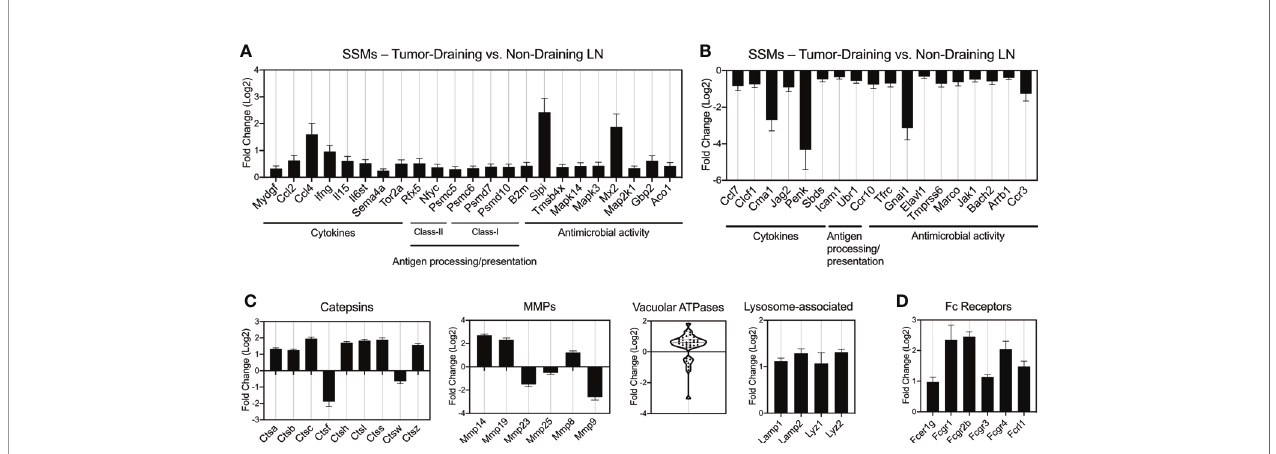
FIGURE 4 | Gene families differentially regulated by tumors in SSMs. (A, B) Immune gene lists from the ImmPort project: cytokines (including chemokines, interferons, interleukins, TNF- and TGFb-family members), genes involved in antigen processing and presentation (class-I and class-II restricted) and genes involved in innate immunity, generally annotated as anti-microbial activity genes. Up-regulated (A) and down-regulated (B) genes are shown. (C) Curated gene families for lysosomal genes (Catepsins, vacuolar ATPases and other lysosome-associated genes) and matrix metalloproteases (MMPs). (D) Fc receptor genes differentially regulated by tumors in SSMs. All comparisons are between SSMs from tumor-draining lymph nodes versus SSMs from non-draining lymph nodes. Genes with a p- adjusted value < 0.01 and a mean expression > 100 were